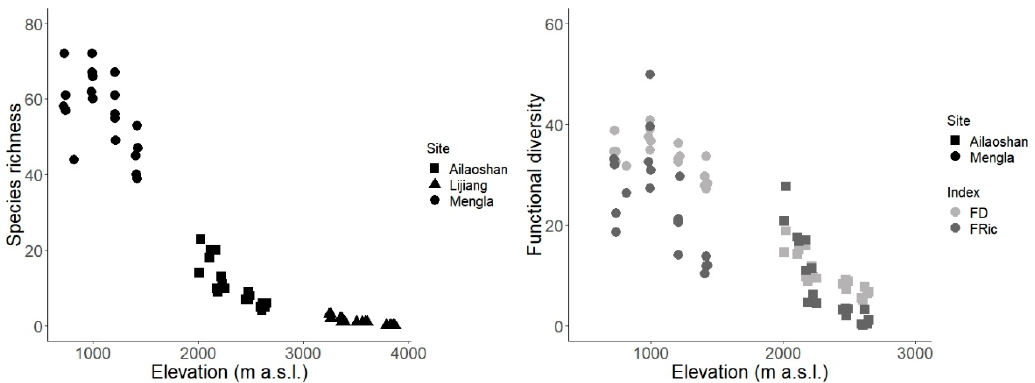
Figure 2. Taxonomic (left) and functional (right, showing FD in light grey and FRic in dark grey symbol) alpha diversity in Mengla (circle), Ailaoshan (square) and Lijiang (triangle) against actual elevation (in m a.s.l.), computed using species with eye length >0. Note the difference in x-axis values, as Lijiang was excluded from functional diversity analyses.